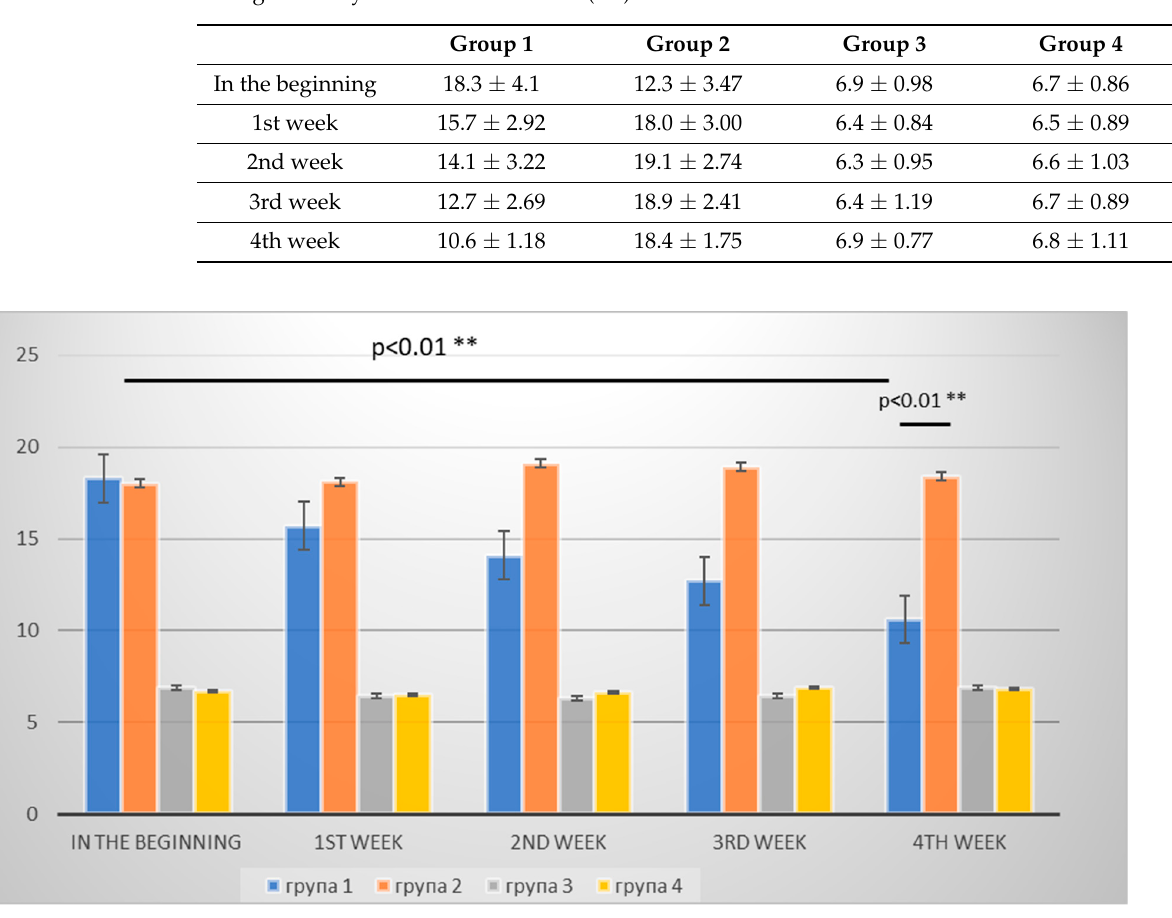
Figure 4. Average levels of immunoreactive insulin, measured in mIU/mL, over the study. Statistical significance: ** p < 0.01. Table 5. Mean levels of HOMA-index in the different groups during the study ± standard deviation (SD).